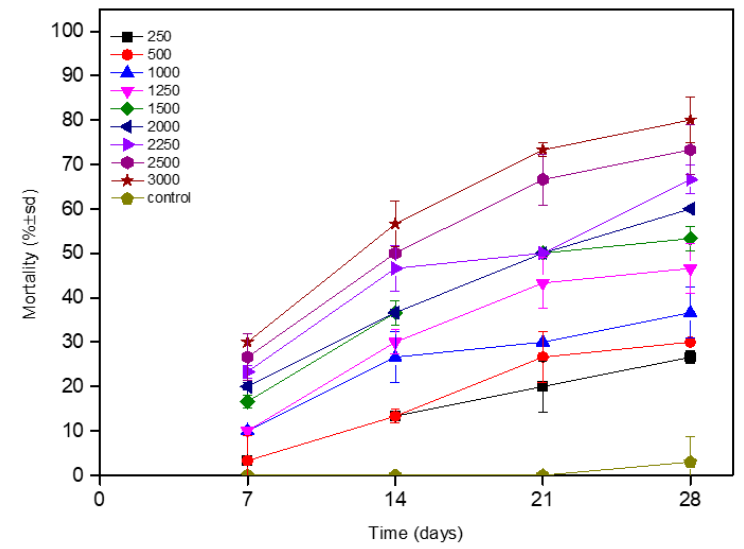
Figure 5. Mean mortality (% ± SD) of T. granarium adults sprayed with six concentrations of cyantraniliprole after 28 days.